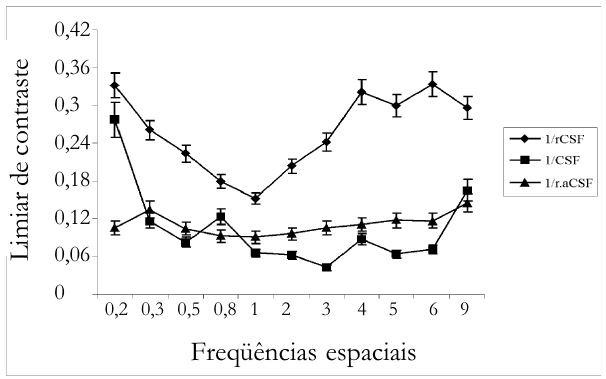
Figura 2 . Curvas de limiar de contraste para freq(cid:252)Œncias radiais (1/rCSF), grades senoidais (1/CSF) e